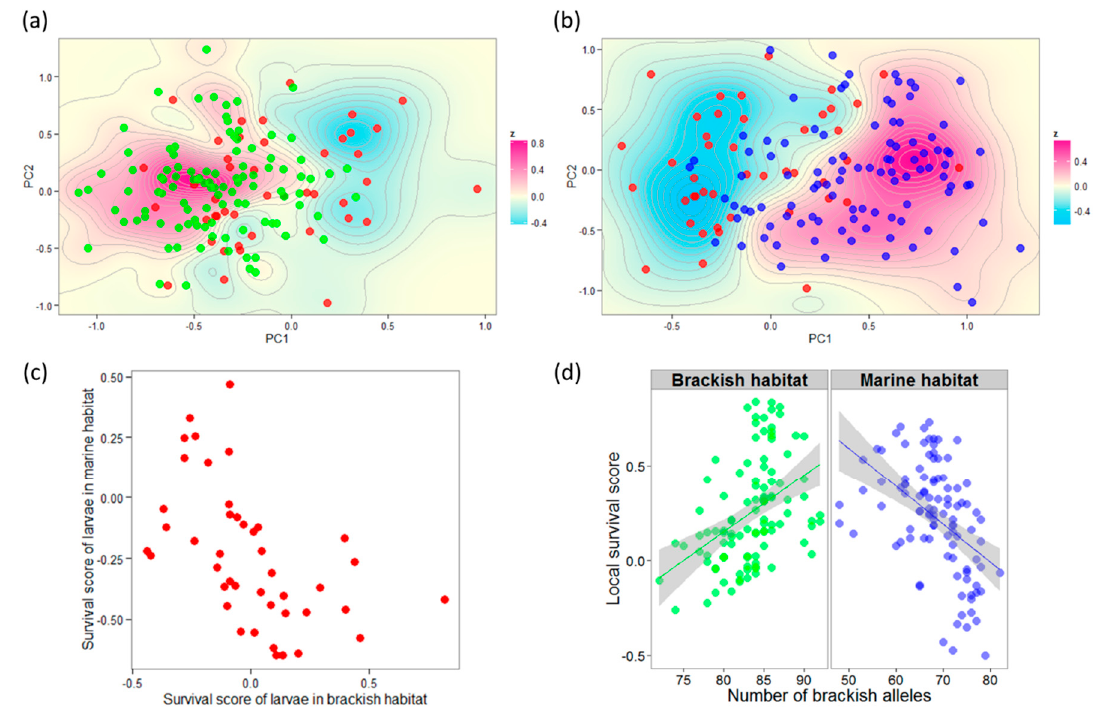
Figure 3. Genotype–fitness relationships assessed with 67 outlier loci detected with the SGS test. Individual coordinates in the two first PCA axes were compared ( a ) between larvae (red) and brackish juveniles (green) or ( b ) between larvae and marine juveniles (blue) to estimate the relative enrichment or depletion of multilocus genotypes over the genotypic space ( z , the relative survival probability score surface) in each habitat. ( c ) Estimated survival scores of larvae show a moderate trade-off between habitats. ( d ) The sum of brackish-favored alleles in individual juveniles is positively correlated with survival score in the brackish habitat but negatively correlated in the marine habitat (ANCOVA interaction term: P = 6.6 × 10 − 11 ).